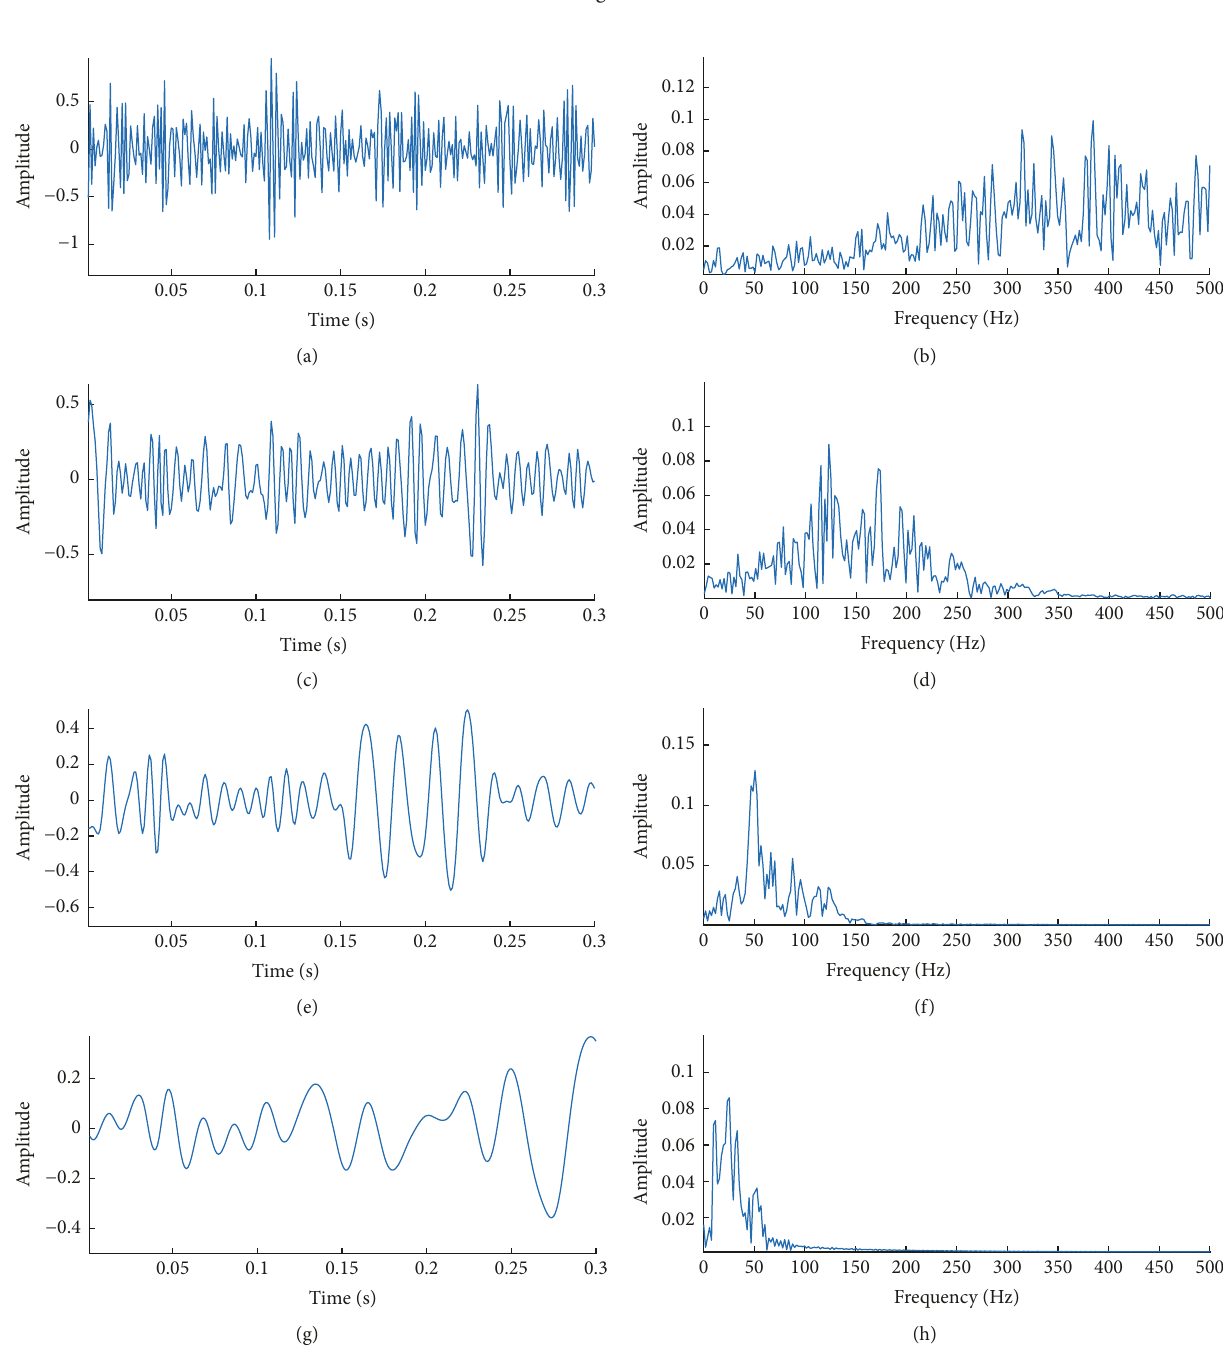
Figure 4: Vibration signal under noise condition.